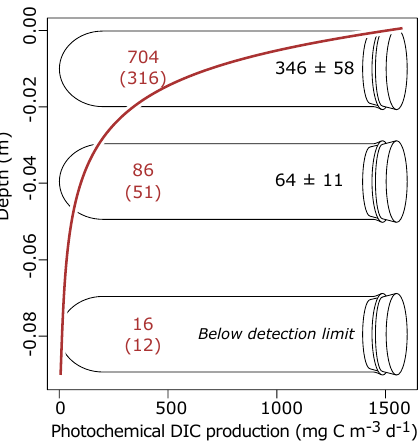
Figure 3. Photochemical DIC production rates observed in situ ( ± SE; black numbers) and simulated using photochemical rate modelling (red curve and average values over the intended depths of the experimental tubes). The frame to which the tubes were at- tached sank into the sediment by about 1cm during the 2 incubation days. Simulated values adjusted to this change in incubation depths are given in